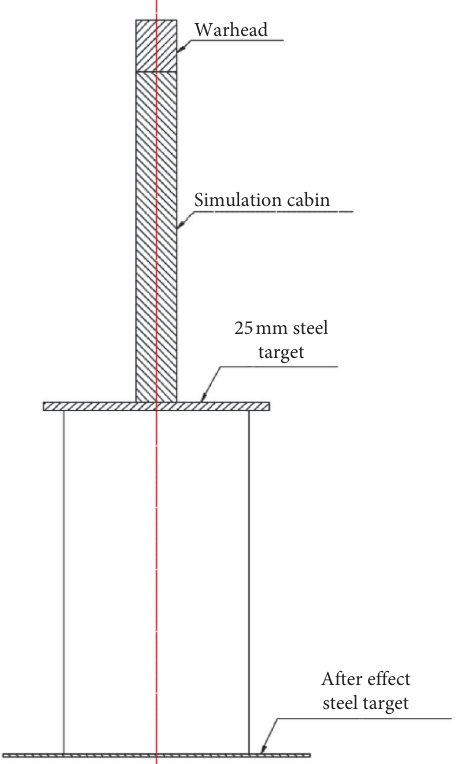
Figure 13: Schematic diagram of the experimental